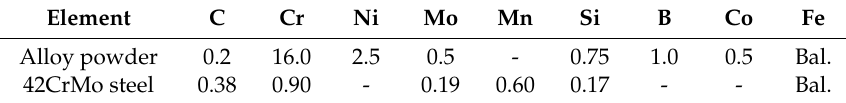
Figure 1. The morphology of Fe-based alloy powder. Table 1. Compositions of the alloy powder the substrate (wt %).